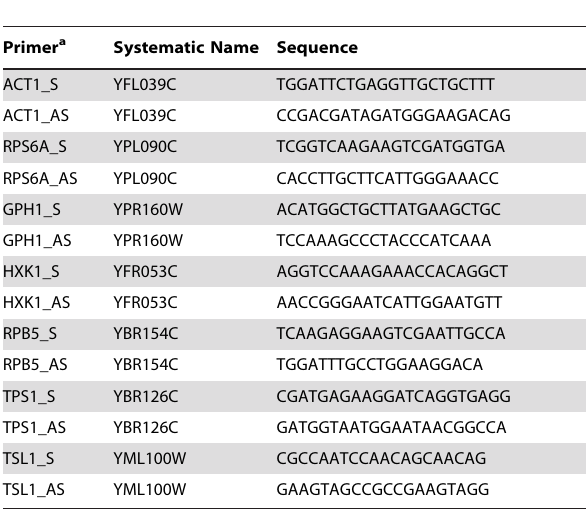
Table 2. Primers used in real-time